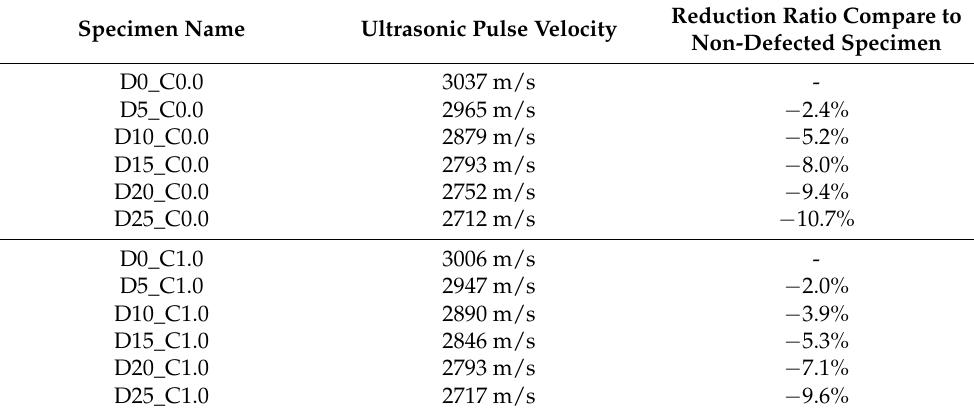
Figure 8. Ultrasonic pulse velocity according to defect size and curing days: ( a ) MWCNT 0.0 wt%; ( b ) MWCNT 1.0 wt%. Table 2. Ultrasonic pulse velocity of nano-cementitious composite on 30 curing